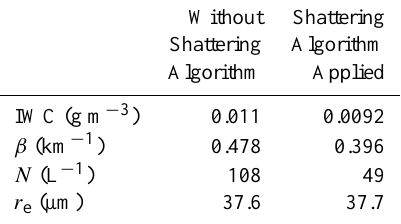
Table 3. Table shows in-situ estimates of IWC, the extinction coef- ficient β , number concentration N , and effective radius r e from the 2D-S probe for the 17 March large crystal case. Estimates without and with a shattering algorithm applied are shown in the left and right columns,